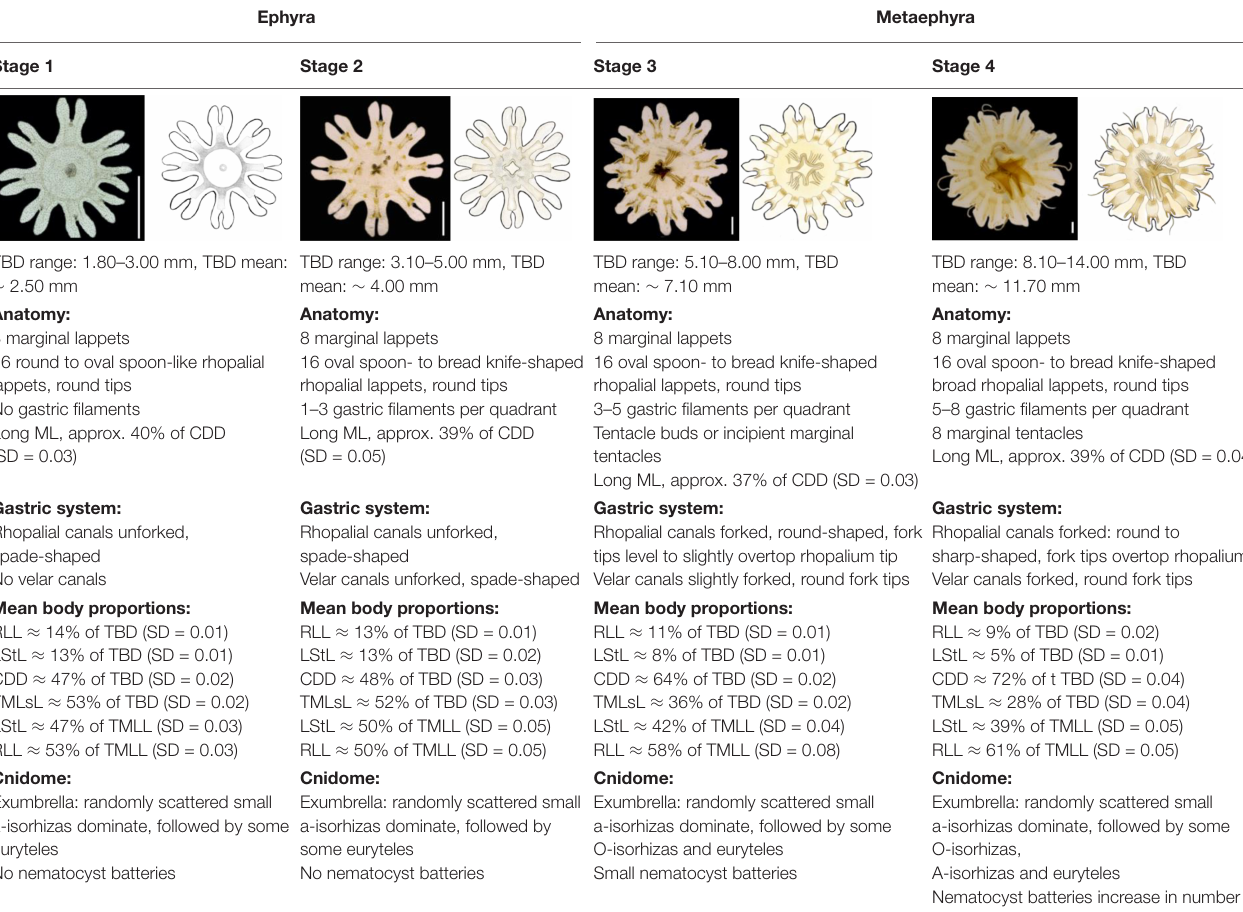
TABLE 1 | Morphology, body proportions and cnidome of the early stages of Pelagia noctiluca life cycle. Ephyra